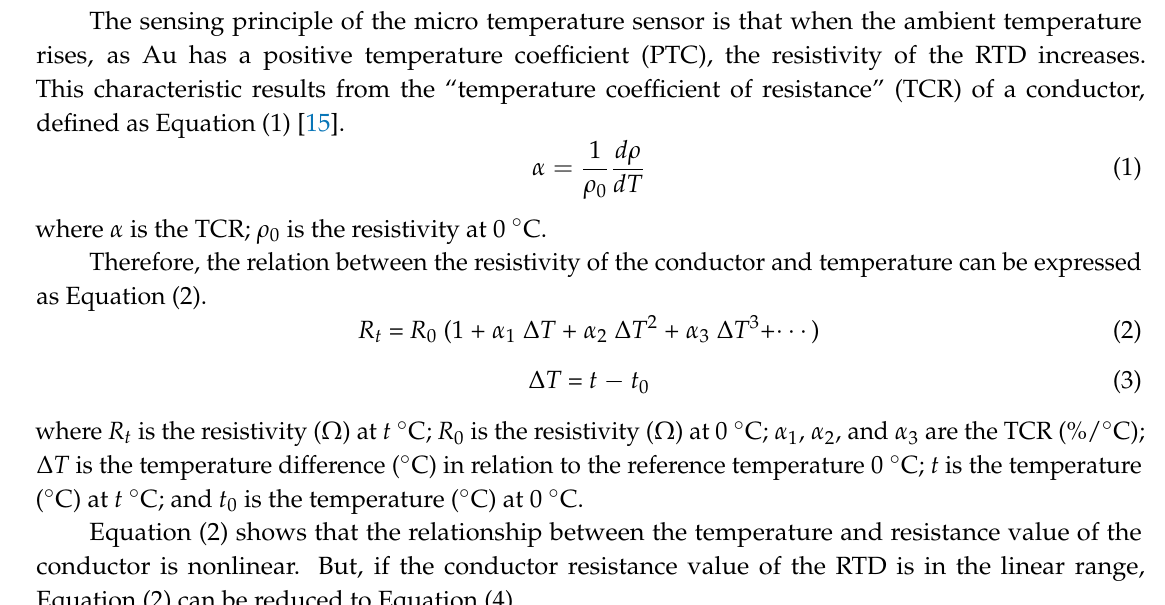
Figure 1. Schematic diagram of temperature sensor.